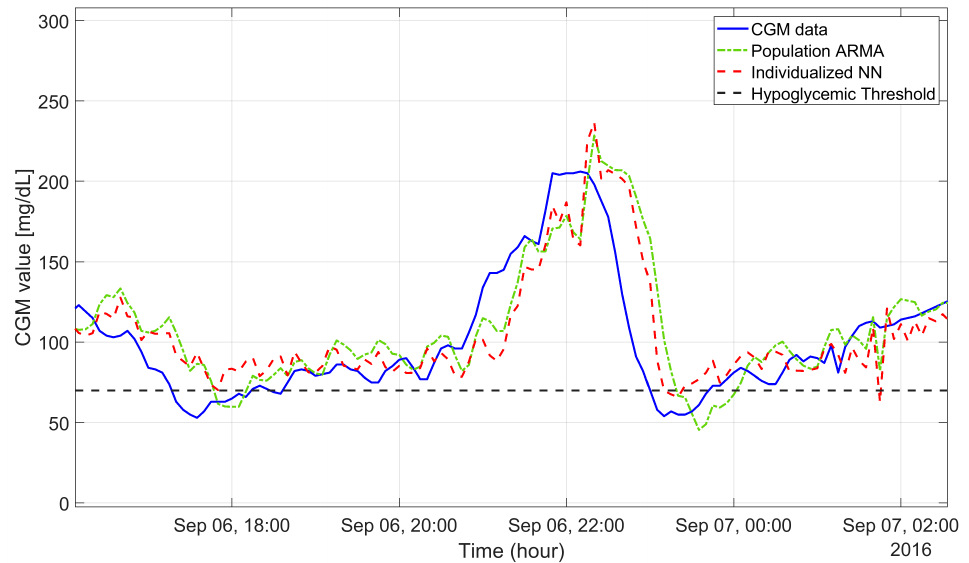
Figure 4. CGM data (blue line): 30-min-ahead prediction obtained with population ARMA(4,1) (green dash-dotted line) and individualized neural network (red dashed line). Hypoglycemic threshold is shown by black dashed